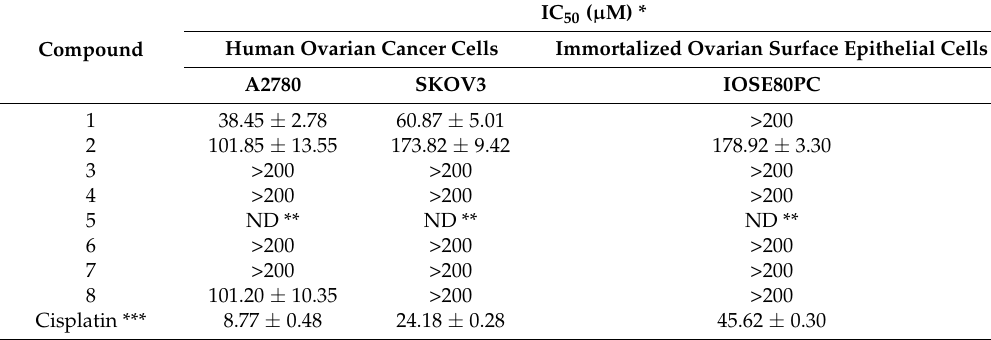
Table 2. Cytotoxicity of compounds 1 – 8 from the EtOAc-soluble fraction of the roots of A. sieboldii in human ovarian cancer cells (A2780 and SKOV3) and immortalized ovarian surface epithelial cells (IOSE80PC).